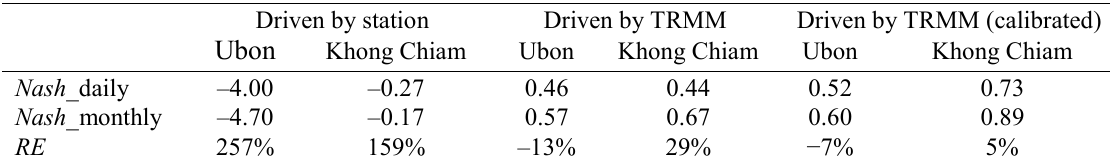
Table 1 The performance matrix of model driven by different data in